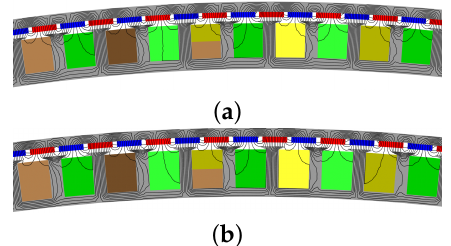
Figure 19. Cross sections of optimized 3MW Type-B PMVMs: ( a ) (1/27th) of Type-B PMVM with Qs/ps/pr = 270/67/203, ( b ) (1/28th) of Type-B PMVM with Qs/ps/pr =